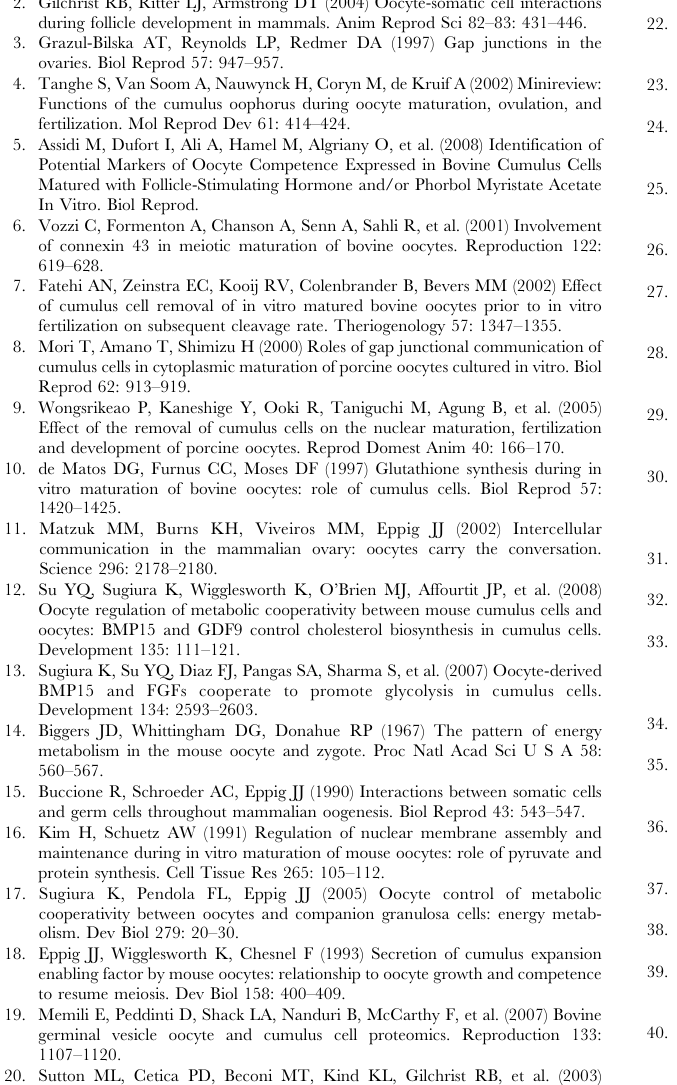
Table S2 List of differentially expressed proteins in cumulus cells compared with GV oocytes. Gene name, numbers of peptides, Sequest cross correlation ( S Xcorr) score and P value for of each differentially expressed protein in GV oocyte and cumulus cells.